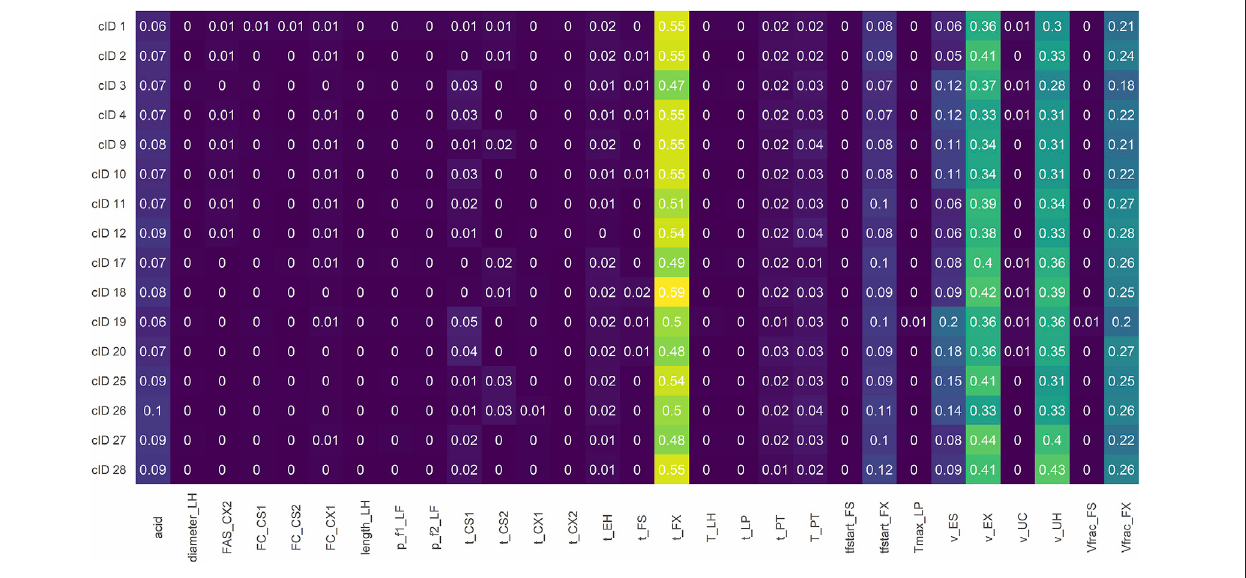
FIGURE 4 | Heatmap of the total sensitivity indices for each fl owsheet option and each operational variable (nonexistent variables are indicated with